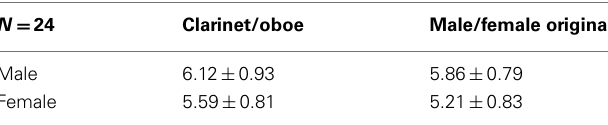
Table 2 | Mean PSE and SD for the bass clarinet and original voices stimuli split by participant’s gender.